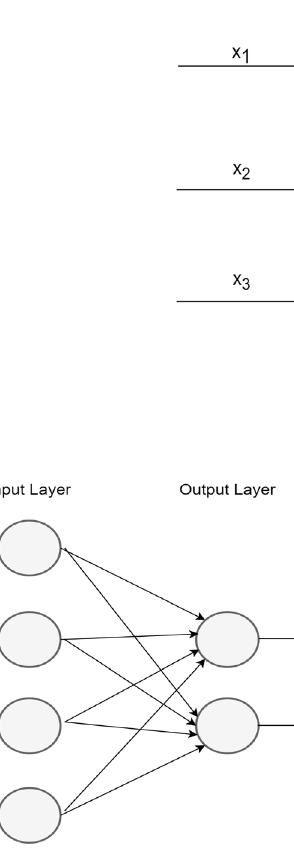
Fig. 3 Feed forward network. Source : [5]